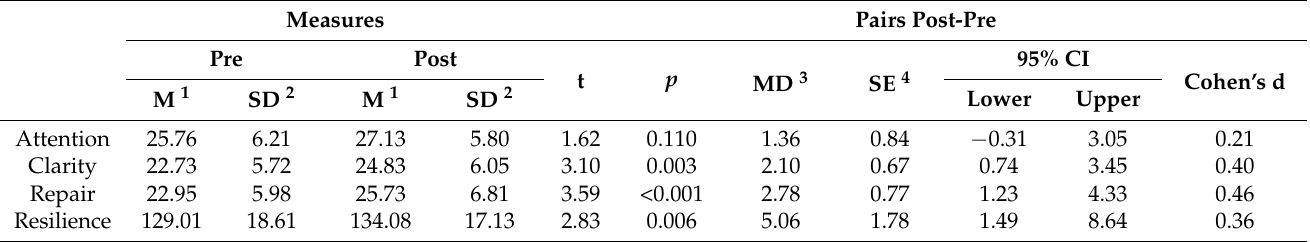
Figure 1. Vovk-Sellke maximum p -ratio (Emotional attention) (Note. Based on a two-sided p -value, the maximum possible odds in favor of H 1 over H 0 = 1/( − e p log( p )) for p ≤ 0.37 [46]). The statistically significant differences between the measurements before and after the non-technical skills training program are shown in Table 3, and graphically in Figure 2. Table 3. Emotional intelligence and resilience. Paired samples Student’s t